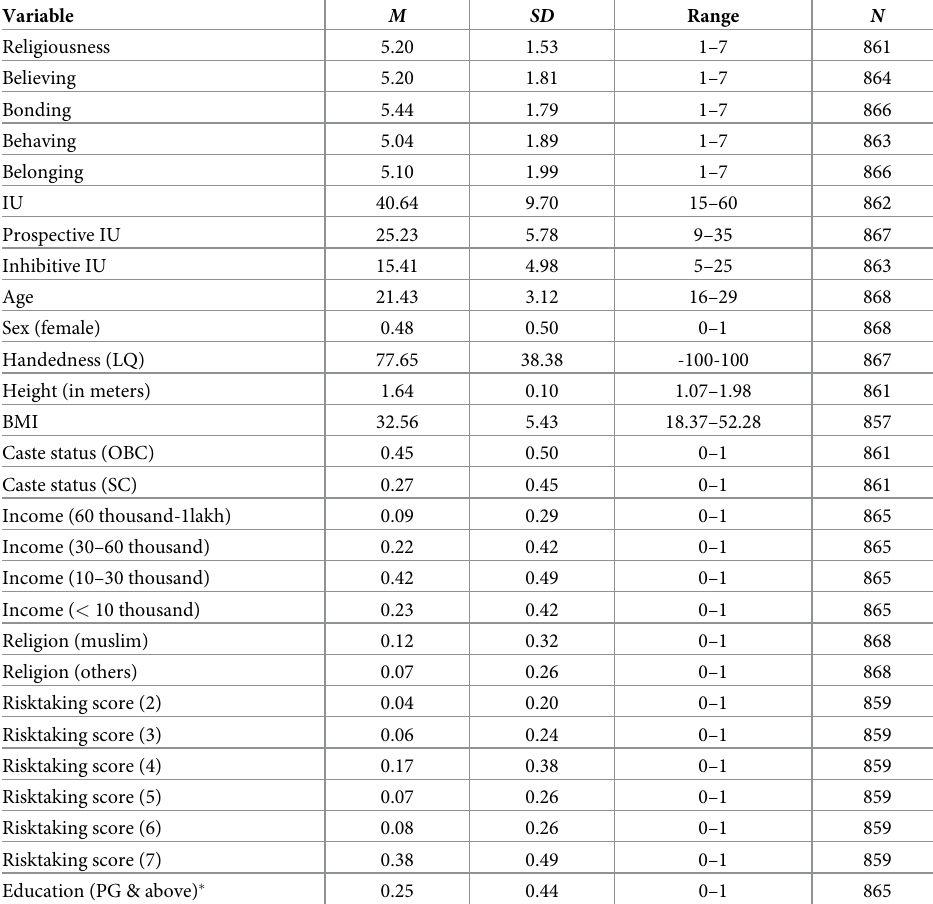
Table 1. The distribution of variables in the students